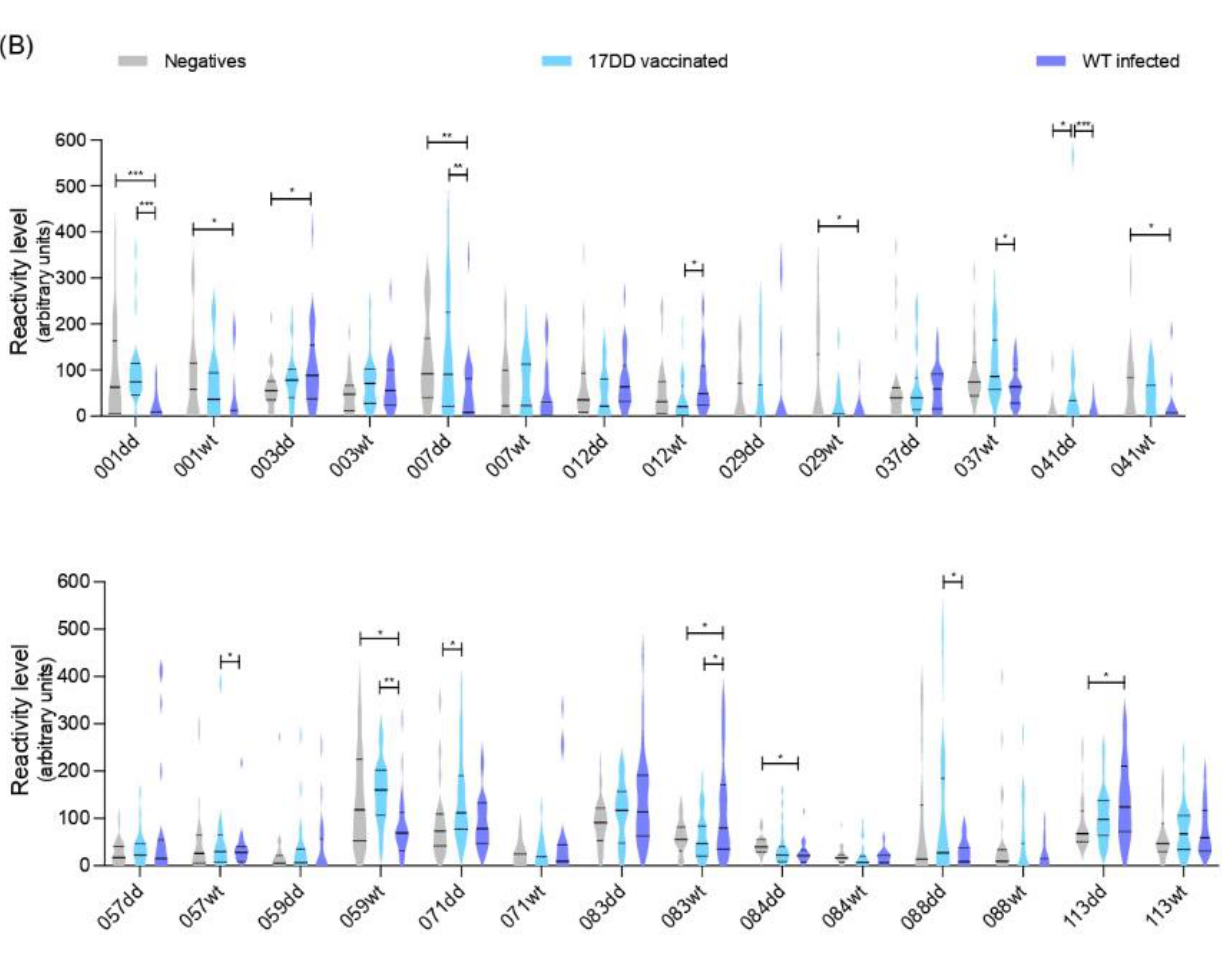
Figure 2. Recognition pattern of each tested peptide by antibodies in sera collected from YFV-vaccinated individuals, WT-infected individuals, or control sera (negatives). ( A ) Heatmap was generated by plotting the median obtained by the reading of each triplicate of the 222 peptides incubated with one of all the collected serum samples. Negative values were corrected to zero. A color scale representing all the reactivity levels was applied to represent the values ranging from zero (blue) to 250 (red). Statistical differences between groups were identified using two-Way ANOVA with Geisser–Greenhouse correction and Tukey multi-comparison (GraphPad Prism). Differences between groups with p < 0.05 are highlighted on the heatmap (in bold). Dashed bars represent statistical differences between groups. ( B ) Violin plot highlighting the statistical differences between groups identified using two-Way ANOVA with Geisser–Greenhouse correction and Tukey multi-comparison (GraphPad Prism). Graph was generated by plotting the median obtained from the reading of each triplicate of the 16 peptides incubated with one of all the collected serum samples. Negative values were corrected to zero. * = p < 0.05, ** = p < 0.01, *** = p < 0.001.